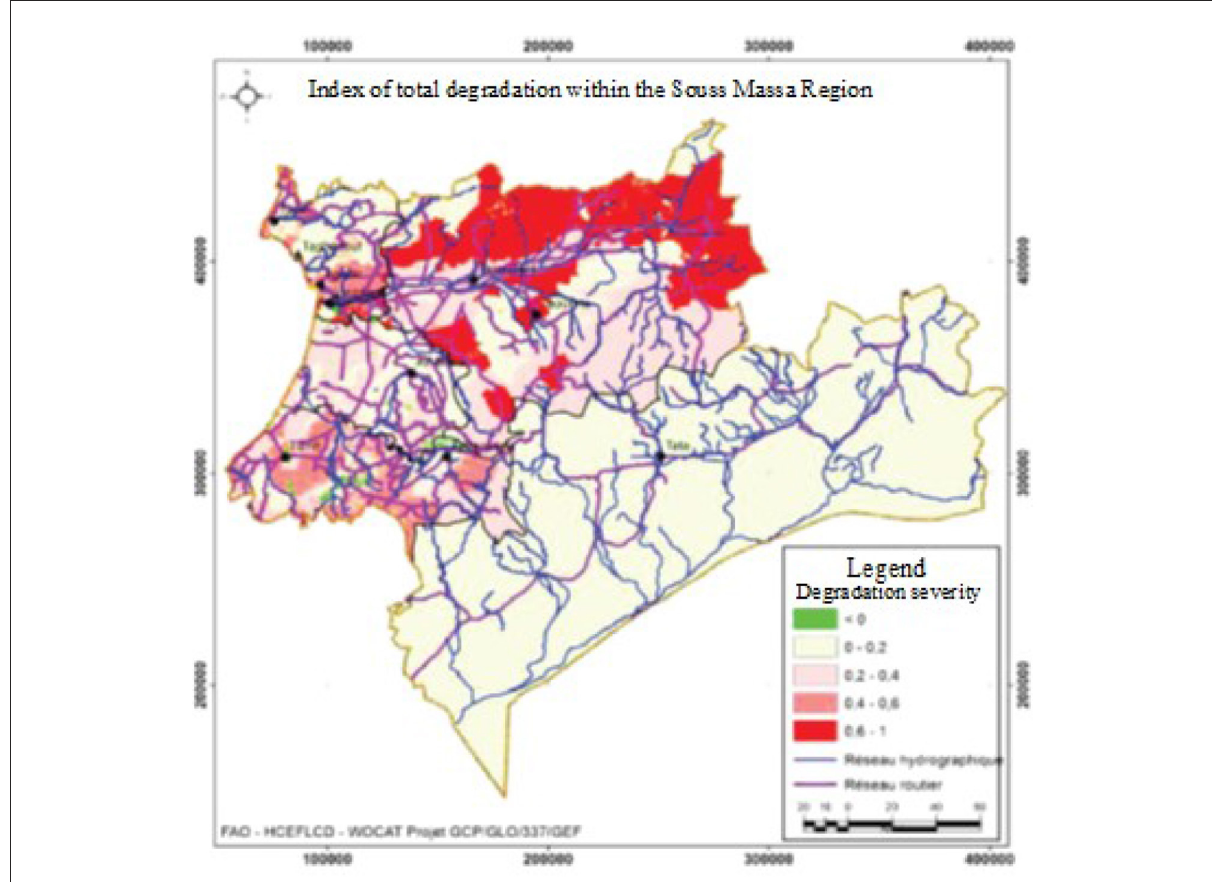
FIGURE8 Map showing Index of total degradation or severity in the Souss-Massa